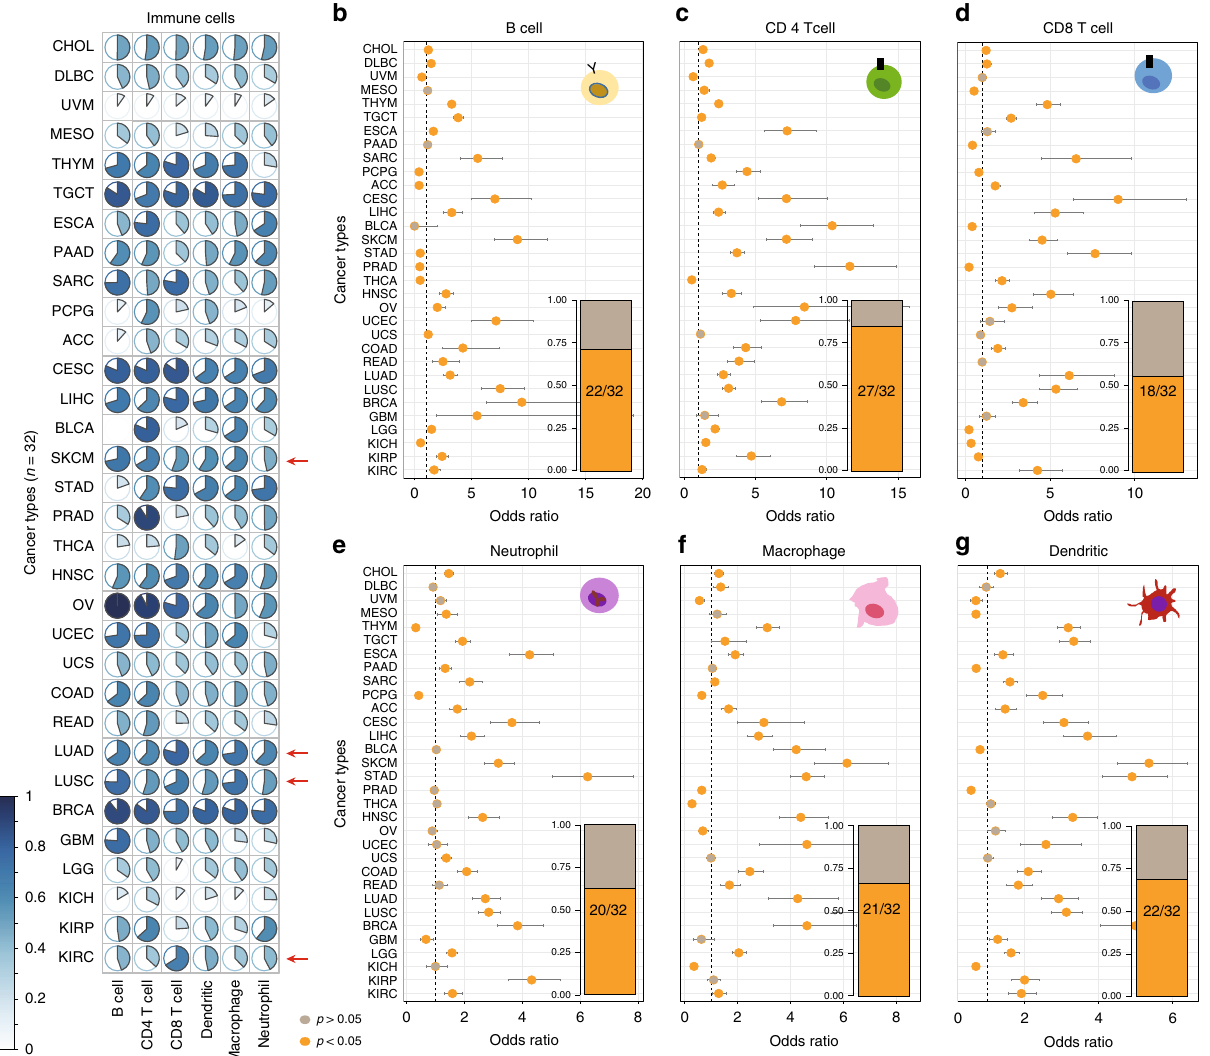
Fig. 3 The immune lncRNAs are correlated with immune cell in fi ltration in cancer. a The proportion of immune lncRNAs that were correlated with immune cell in fi ltration. b – g The immune-related lncRNAs were likely to be enriched in lncRNAs that were correlated with immune cell in fi ltration. The dots represent the odds ratio (OR) of Fisher ’ s exact test and the error bars show the 95% con fi dence intervals of the OR. The numbers inside bar plots show the proportion of cancers, where orange indicates cancers with P -values < 0.05 and OR > 1 in two-sided Fisher ’ s exact test. b B cells; c CD4 T cells; d CD8 T cells; e neutrophils; f macrophages; and g dendritic cells. Source data are provided as a Source Data